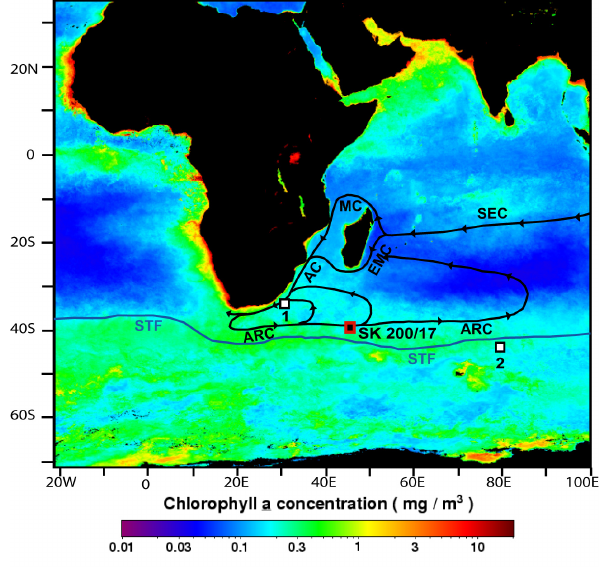
Fig. 1. The location of core SK 200/17 is marked with a red square. The surface circulation in this region, which includes the South Equatorial Current (SEC), Mozambique Channel (MC), East Madagascar Current (EMC), Agulhas Current (AC) and Agulhas Retroflection/Return Current (ARC) is marked with black lines. The position of the subtropical front (STF) is marked with a thick dark blue line. The other cores discussed in the text are also marked as 1 (MD962077, Bard and Rickaby, 2009) and 2 (RC11-120, Mashiotta et al., 1999). The template is the average productivity in terms of chlorophyll a concentration in mgm − 3 . The chloro- phyll data was downloaded from the ocean color web page (http: